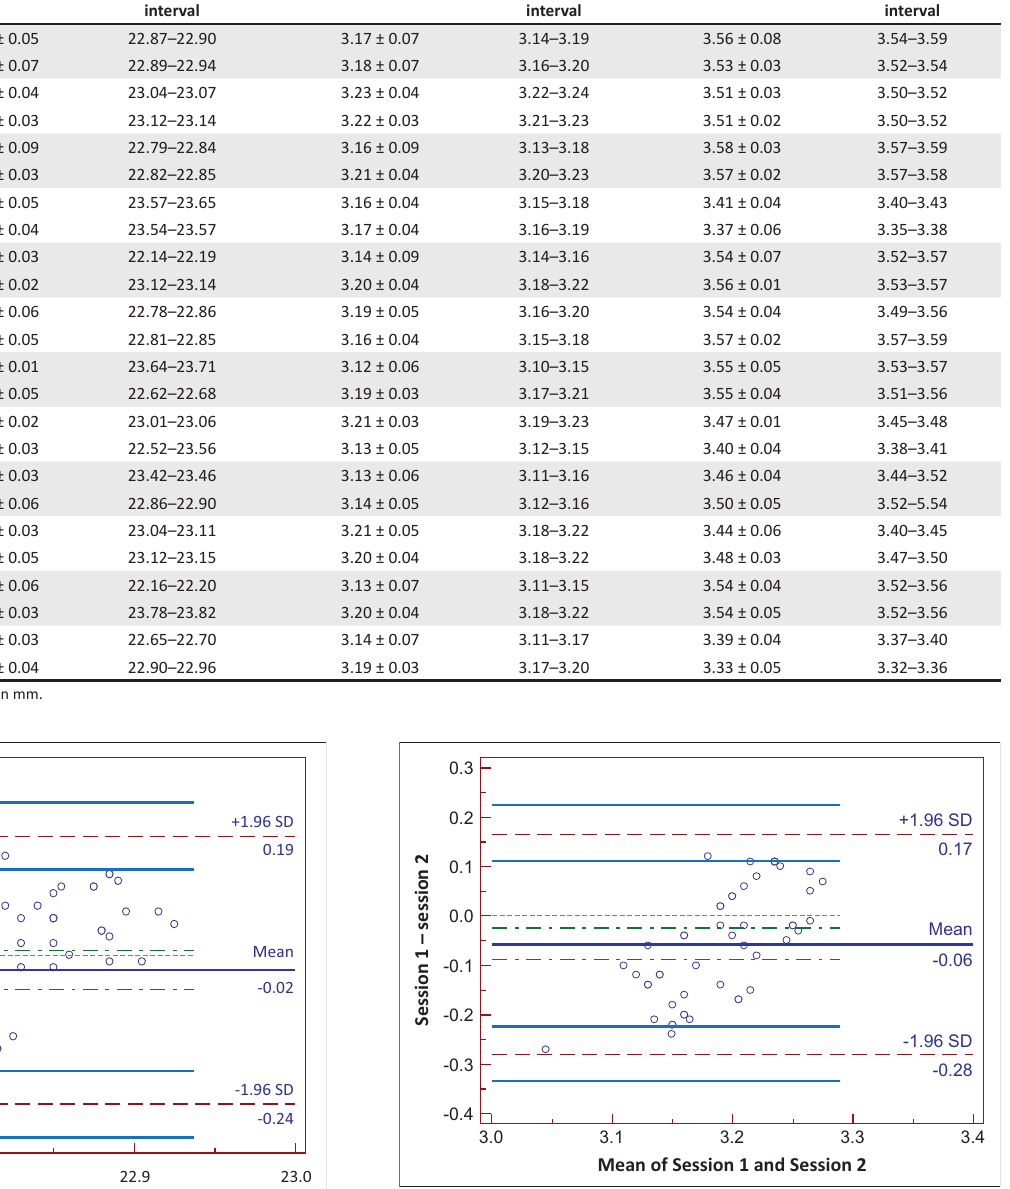
FIGURE 2: The Bland-Altman plot showing inter-session reproducibility (session 1 − session 2) in anterior chamber depth measurements for Subject 3. The mean difference (-0.06 mm) is